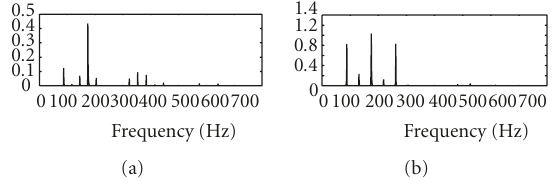
Figure 8: Frequency responses of pitches (a) Bb 0 and (b) F 1 using